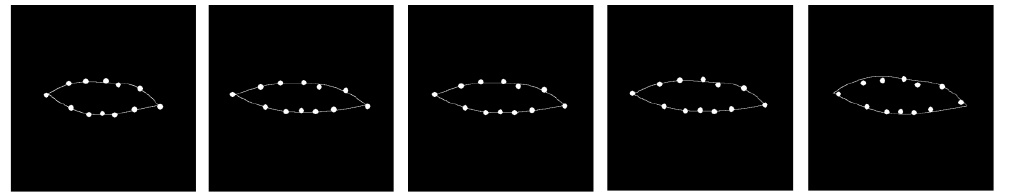
Figure 12. Example of model fits at five time points during specific trajectory for a single subject via mPCA for the frontal/coronal plane. (Increasing time is shown from left to right.) Points for the raw data are shown by the filled circles and the model fits are given by the curved lines.